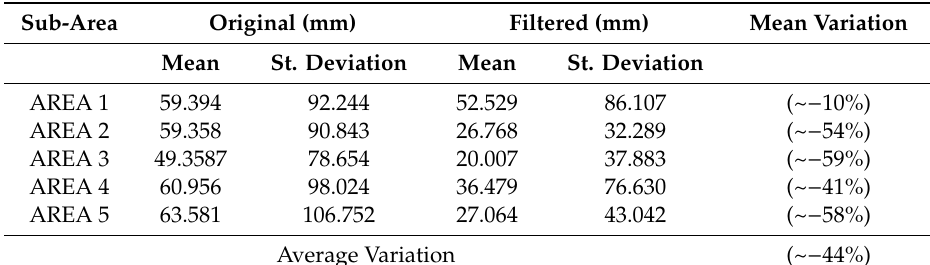
Figure 10. Selected five areas for cloud-to-cloud distance analyses between the laser scanning ground truth and the two photogrammetric clouds. Table 11. Cloud-to-cloud distance analyses on the original and filtered dense cloud and average variation of the mean values.